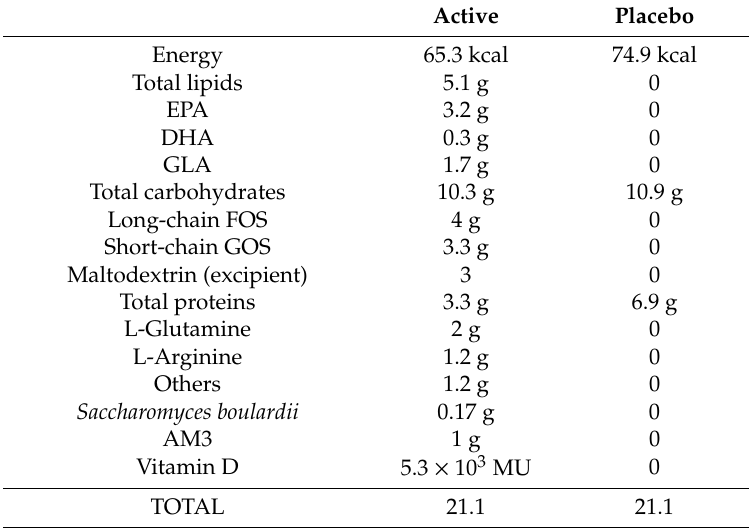
Table 1. Product composition: Intake per day. Active